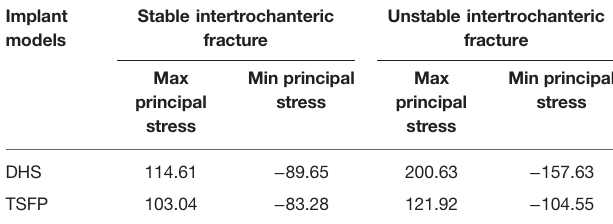
TABLE 2 | The maximum displacement and stress values of two implant models for the treatment of stable intertrochanteric fracture. Implant models